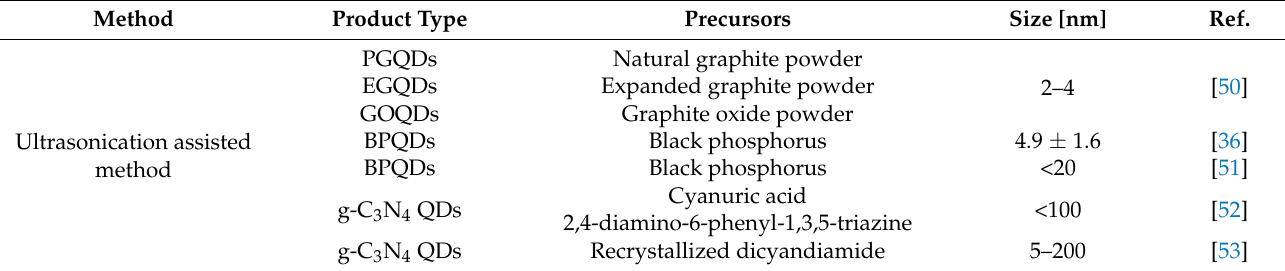
Table 1. Synthesis of 2D-QDs by top-down